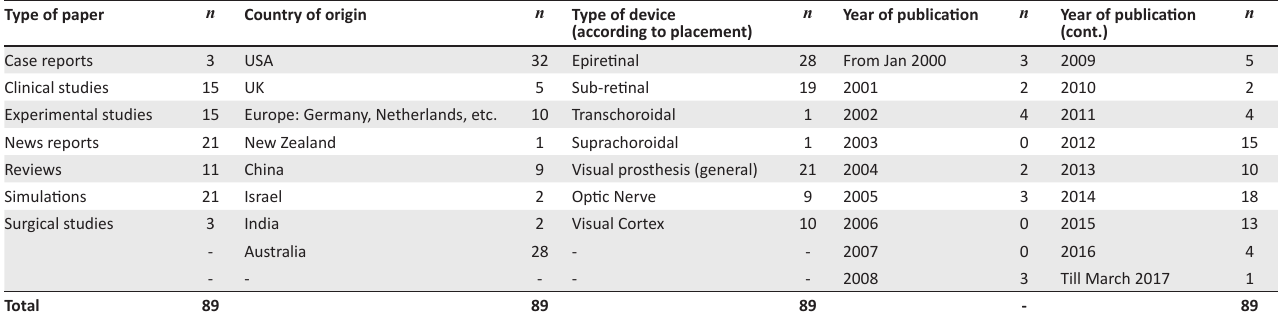
TABLE 1: Summary of included articles.